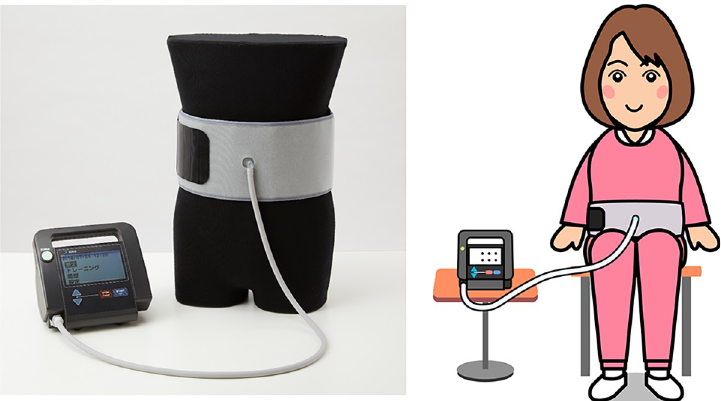
Fig 1. Novel exercise device for abdominal trunk muscles. (Left) Photograph of the device. (Right) Artistic rendering of a patient wearing the device.